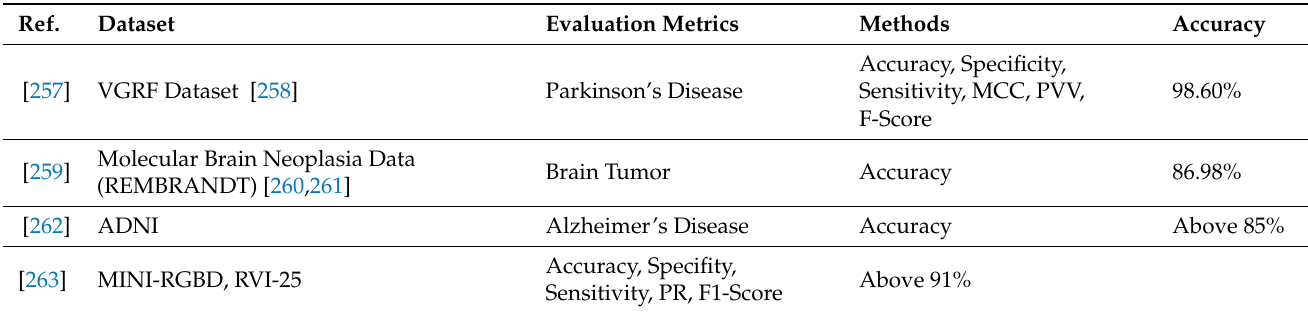
Table 16. LSTM classifier result analysis on various NDs.